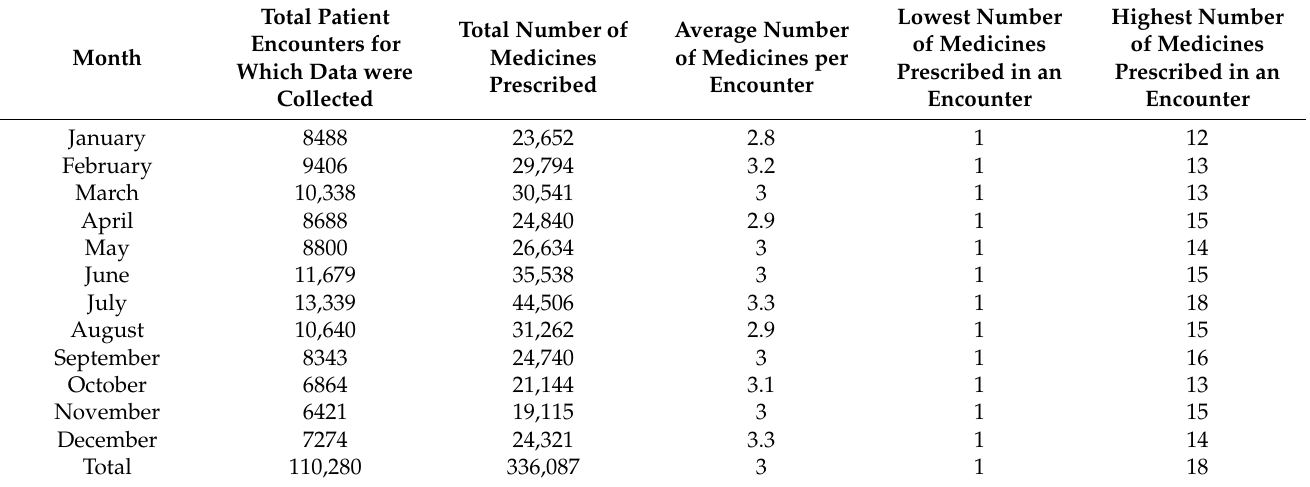
Table 2. Average number of medicines prescribed per patient encounter among outpatients at University Hospital, KNUST in 2021.